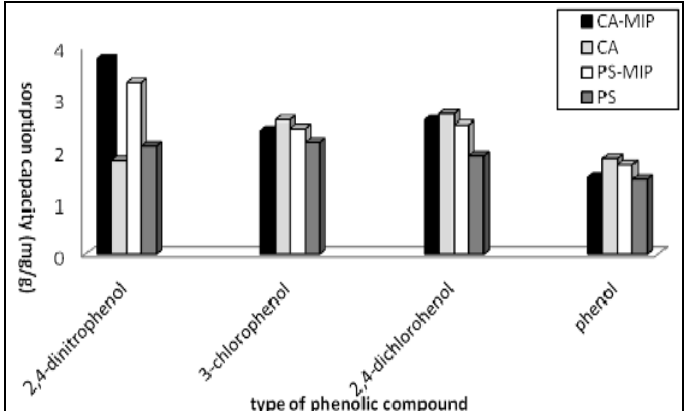
Figure 9. Selectivity study of the removal of 2,4-DNP by CA-MIP and PS-MIP in the presence of various phenolic